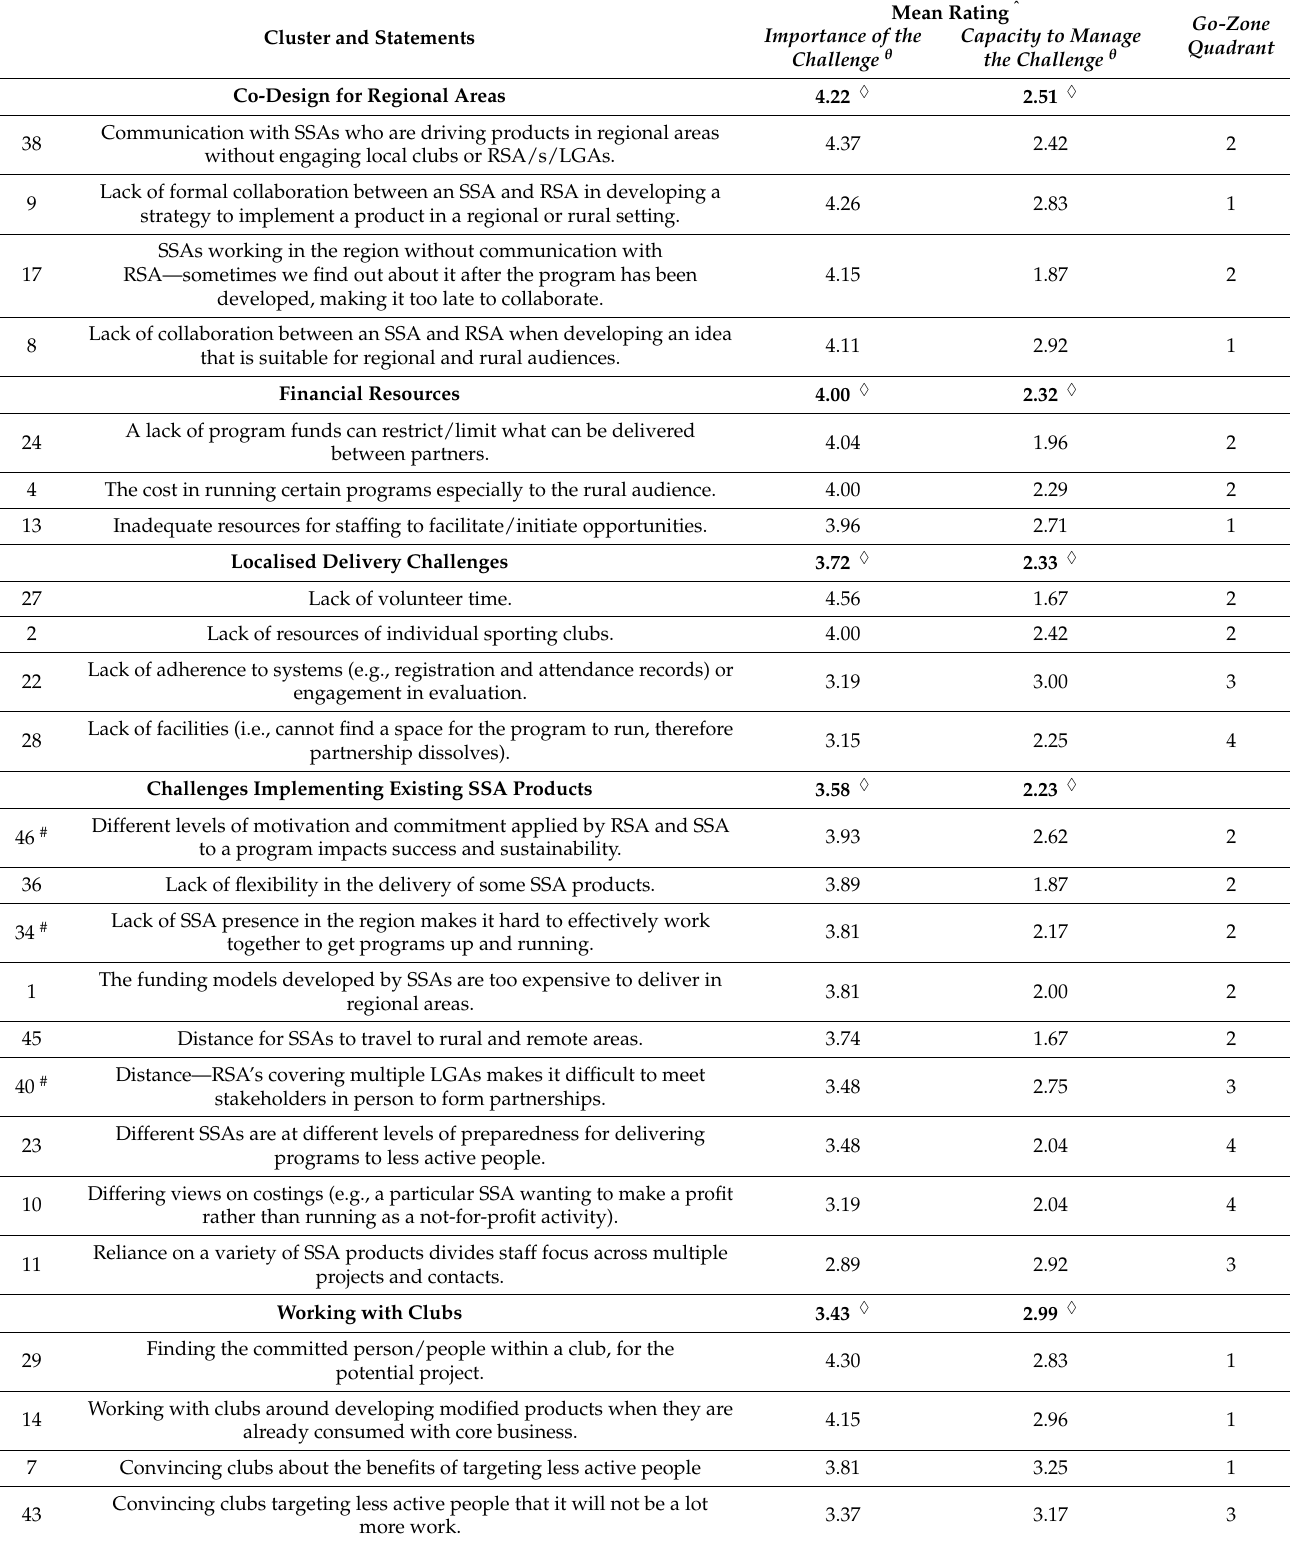
Table 2. Regional Sports Assembly partnership-related challenges generated during the Concept Mapping brainstorming process including the cluster in which each statement fits, mean importance and capacity to implement ratings for each